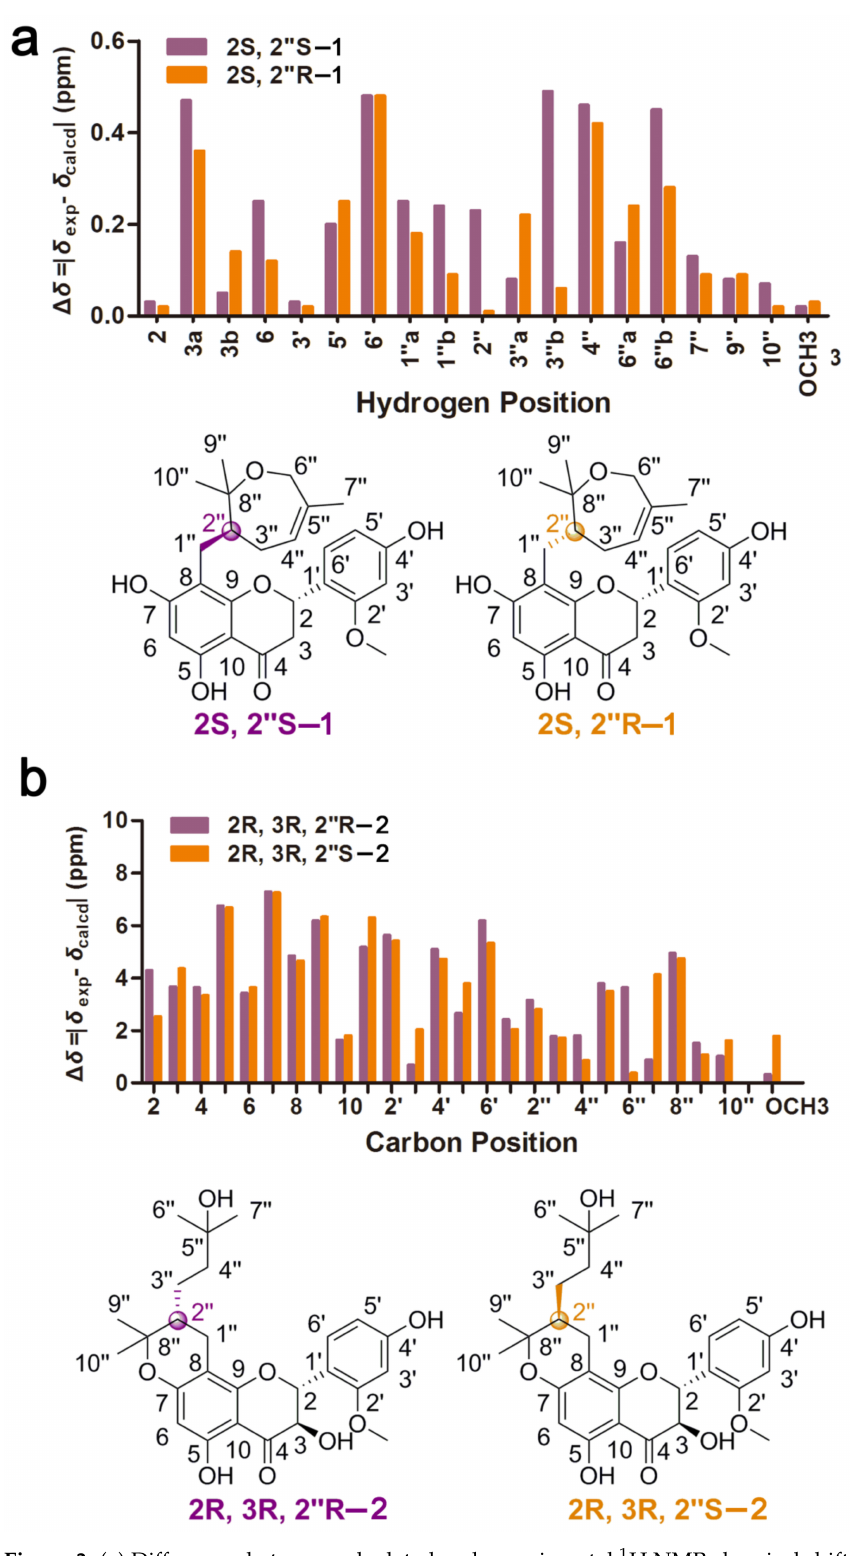
Figure 3. ( a ) Differences between calculated and experimental 1 H NMR chemical shifts for 2S, 2 (cid:48)(cid:48) S- 1 and 2S, 2 (cid:48)(cid:48) R– 1 ( b ) Differences between calculated and experimental 13 C NMR chemical shifts for 2R, 3R, 2 (cid:48)(cid:48) R– 2 and 2R, 3R, 2 (cid:48)(cid:48) S– 2